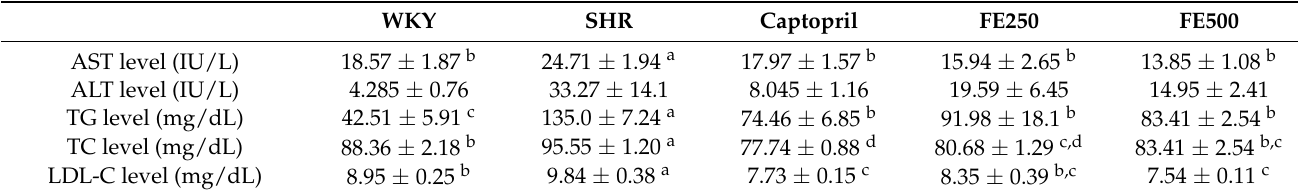
Table 2. Effects of FE supplementation on the serum and plasma biochemical parameters in the WKYs and